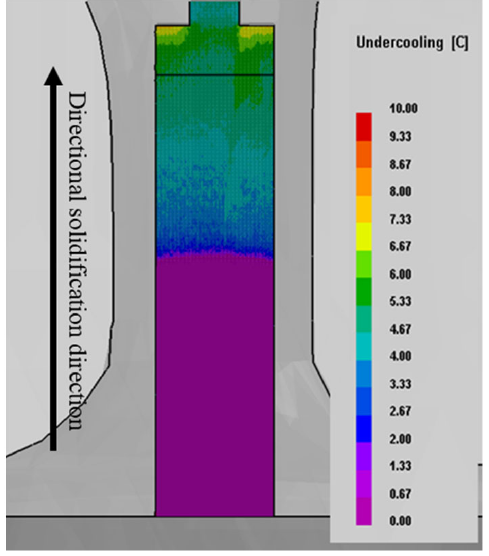
Figure 6. Thermal undercooling during solidification obtained by CAFE simulation with a with- drawal rate of 100 μ m/s.